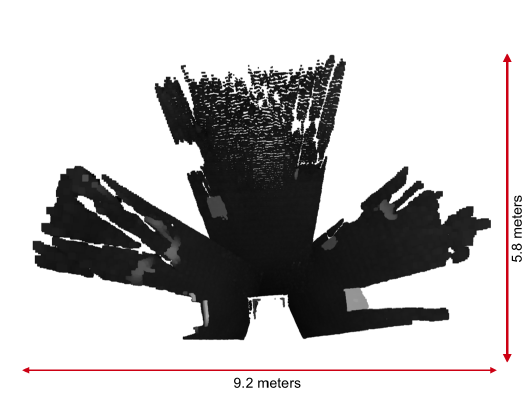
Figure 5: Orthoimage obtained from our system Our localization approach is based on the determination of the mobile displacement observed between orthoimages acquired reg- ularly during the movement. The presented system produces, for each time t , one point cloud of 900000 points. This point cloud is transformed into an orthoimage called O t . The set of orthoimages is denoted O 0: n = O 0 , ..., O n . The determination of the platforms trajectory requires computing the displacement performed between two successive orthoimages. This displace- ment is obtained through the calculation of the transformations parameters T t,t − 1 between the orthoimage O t at time t and the orthoimage O t − 1 at t − 1 . At time t , the position of the platform is defined by equation